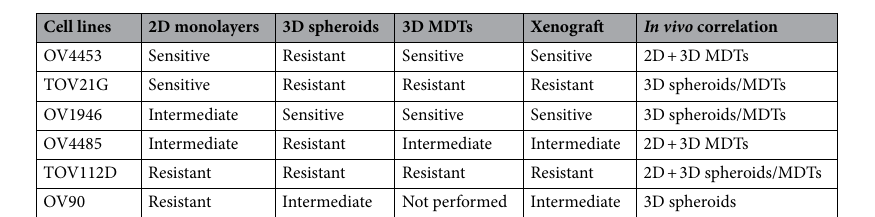
Table 1. Summary of carboplatin sensitivity of EOC cell lines across model systems. MDTs = micro-dissected tissues.